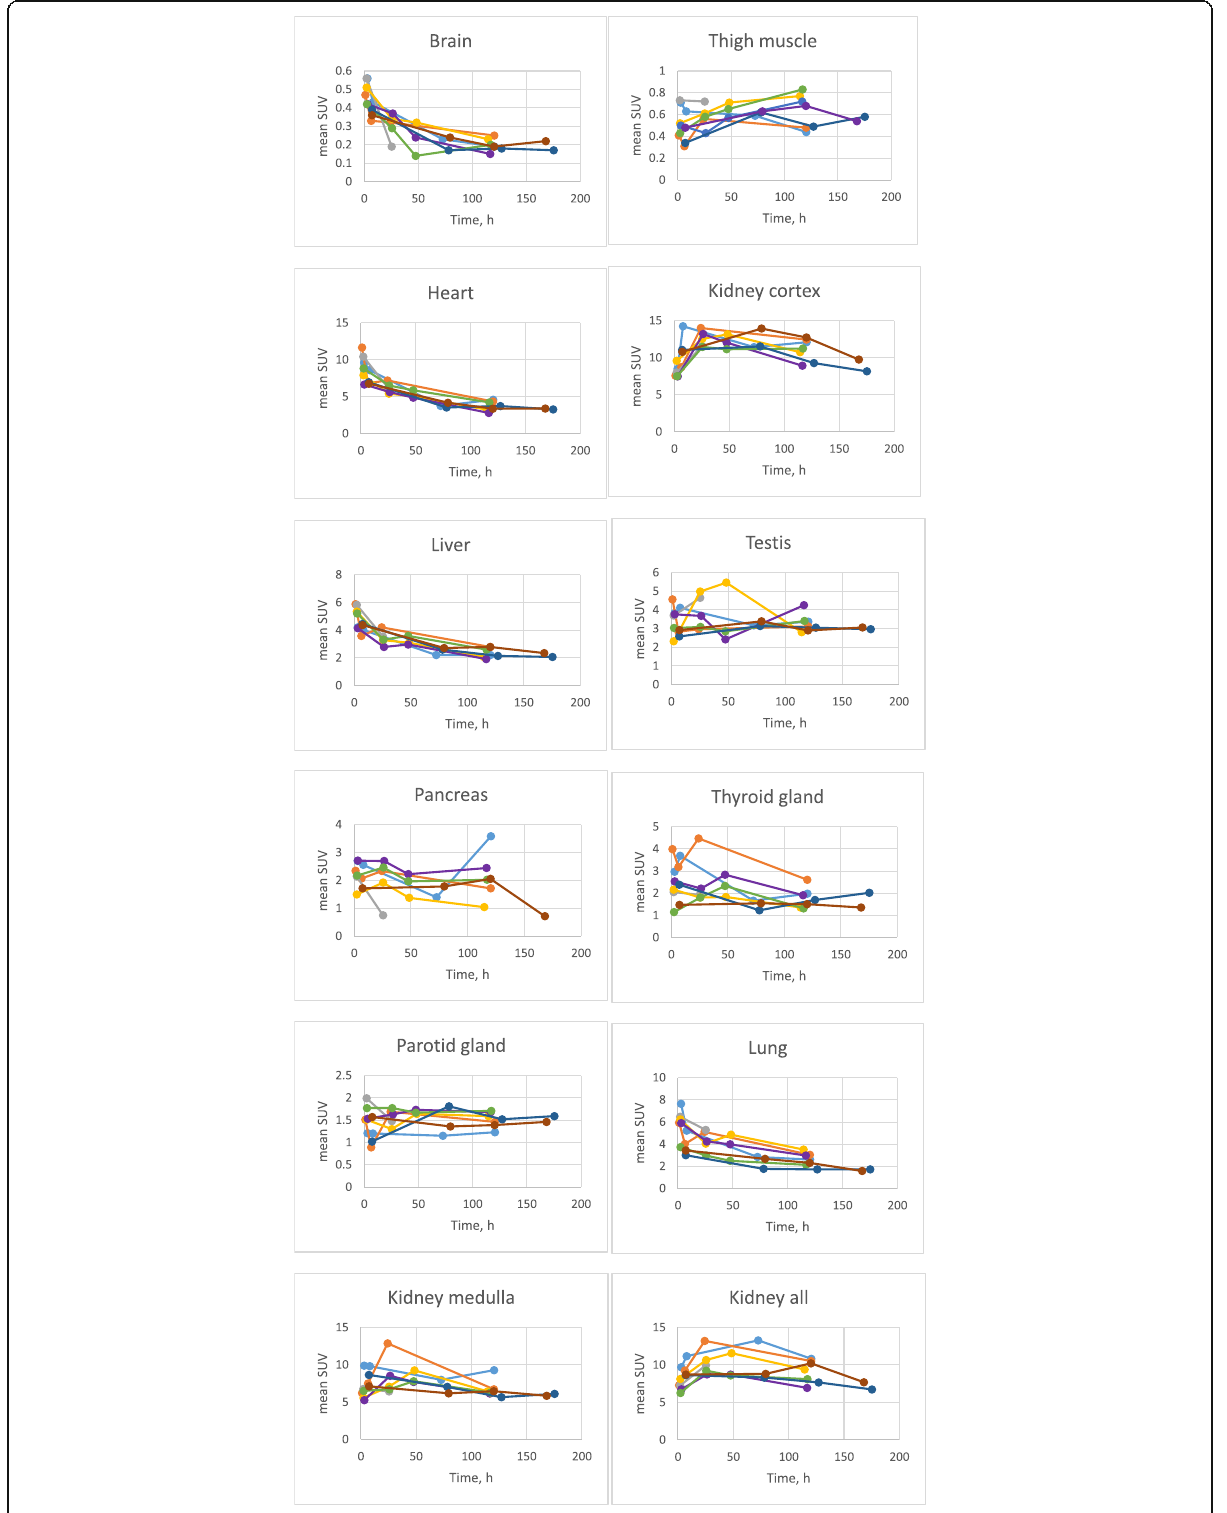
Fig. 3 The SUV time course data for [ 89 Zr]-GSK3128349 tissue distribution. Individual subjects are identified by the color. While some organs could be measured as whole organs (e.g., kidneys, liver, and spleen), some could only be sampled in part (e.g., muscle and lungs). Subject 105- light blue, 110-orange, 122-gray, 123-yellow, 125-purple, 127-green, 132-dark blue,